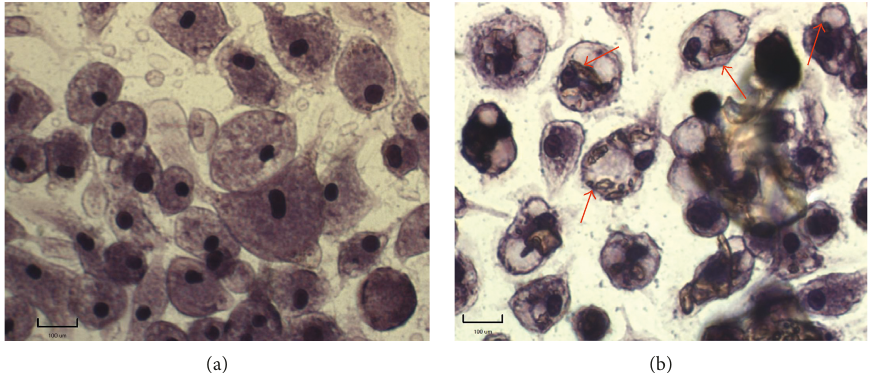
Figure 5: Uptake of ash and vacuolization by peritoneal macrophages: (a) untreated cells and (b) cells treated with 320 µ g/cm 3 and view of cells with internalized and vacuolization of ash particles (arrows). Images are representative of all samples. Staining: hematoxylin and eosin. Scale: 100 μ